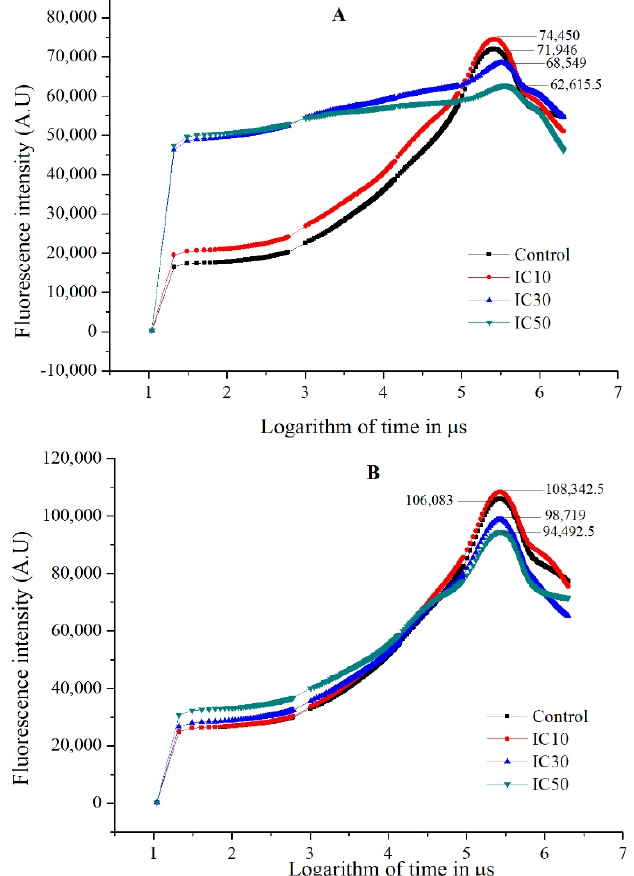
Figure 2. OJIP curves of Scenedesmus obliquus after exposure to different concentrations of tetracycline for 4 days ( A ) and 8 days ( B ).